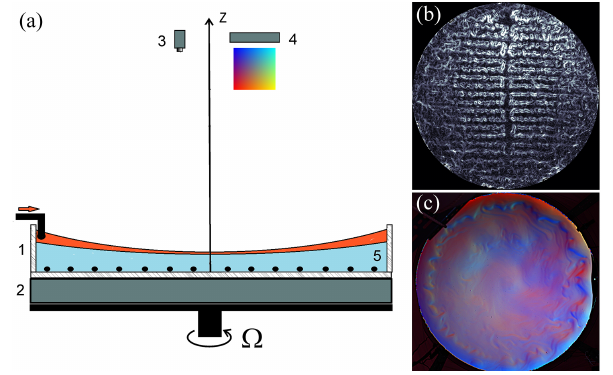
Figure 1. Sketch of the experimental set-up (a) and view of the flow at the beginning of the experiments with the thermal (b) and saline (c) forcing: (1) cylindrical tank filled with water and installed on a table rotating with angular velocity (cid:127) ; (2) light box for the optical thickness measurements; (3) video camera; (4) light source with colour mask; and (5) heating wire on the